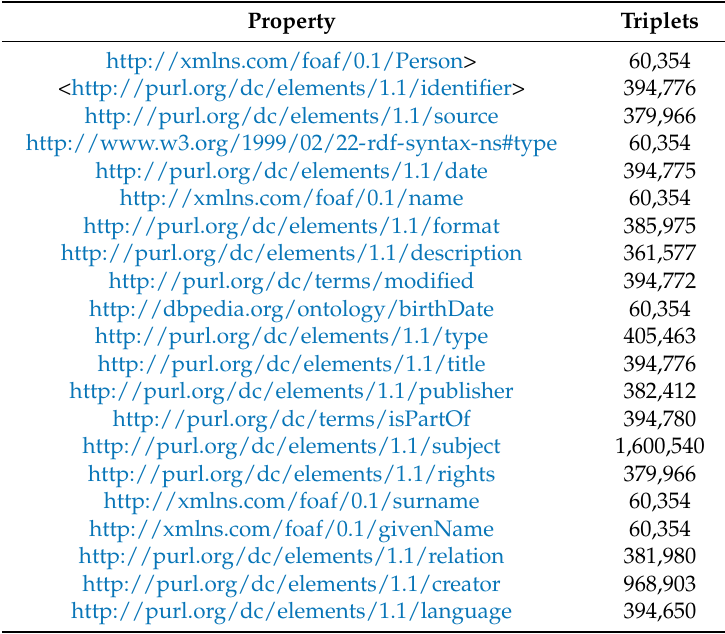
Table 4. Results of loading to TDB.